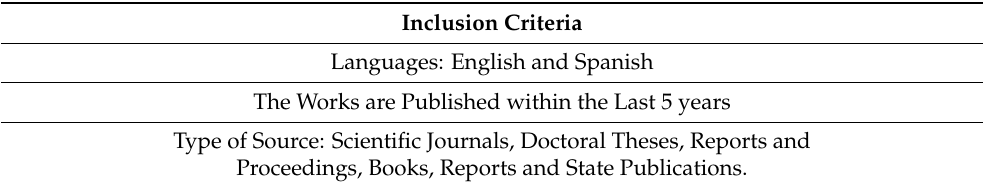
Table 1. Inclusion criteria. Source: own authors.